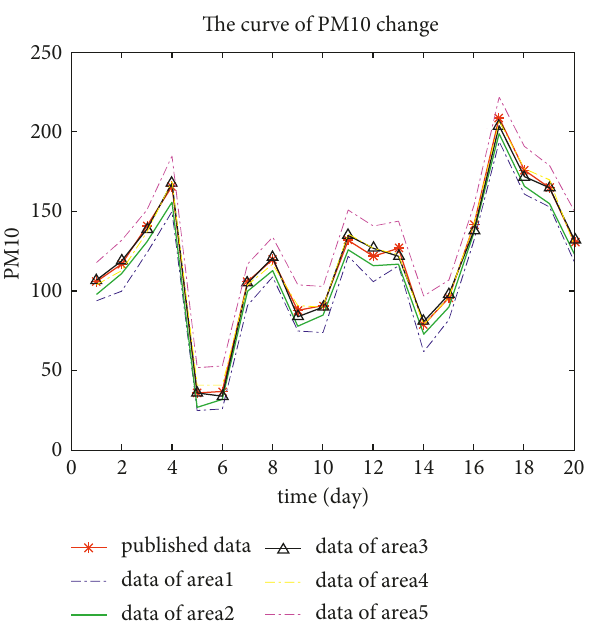
Figure 8: Curve of CO change in different task grid